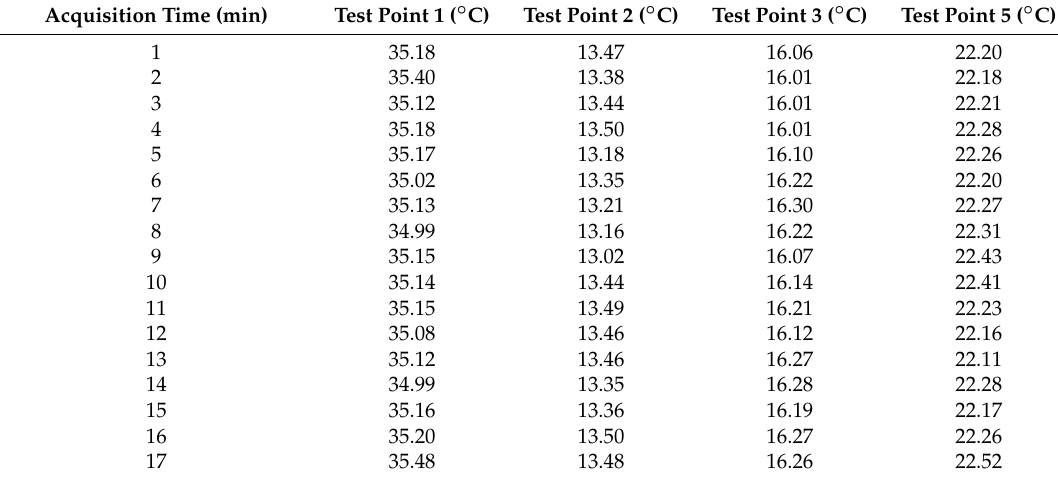
Table 2. Temperature of four test points at 35 ◦ C, 80%, 0.3 m 3